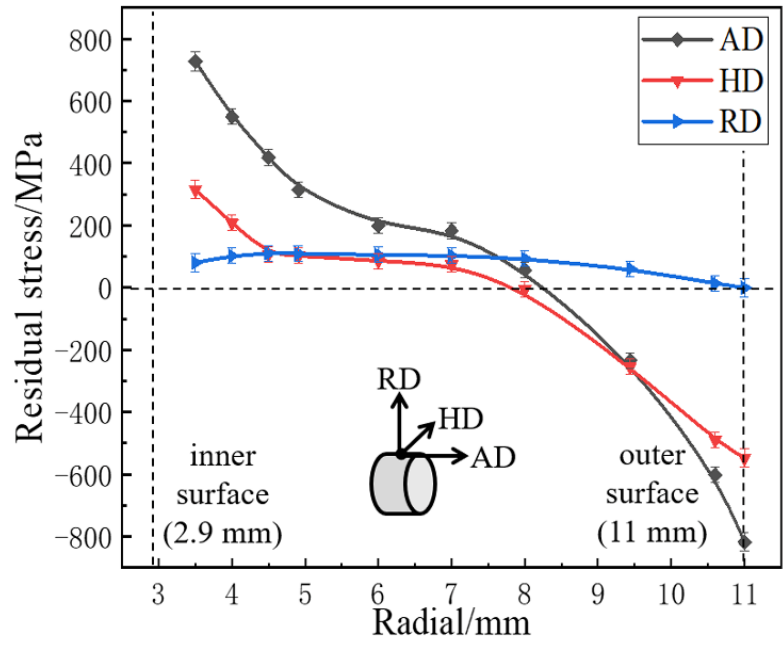
Figure 3. Residual stress distribution of the forged tube with a reduction of 42.7%. The distribution of hardness is uneven in the radial direction of the forged tube. The microhardness of the one-third thickness is lower than the inner surface, as shown in Figure 4. The increase of microhardness is caused mainly by the work hardening of metal. The uneven distribution of hardness is related to the deformation inhomogeneity through the thickness direction. The outer surface of the tube contacts directly with the hammer, and the inner surface contacts with the mandrel. The deformation of the near outer surface is small due to the friction [26]. In order to measure the distribution of microhardness along the thickness direction, a strip of 4 mm (thickness) × 4 mm (width) × 8.1 mm (height) was cut from the section of the forged tube. Since the size is small enough, the residual stress of the measured strip has been released. The influence of residual stress on the